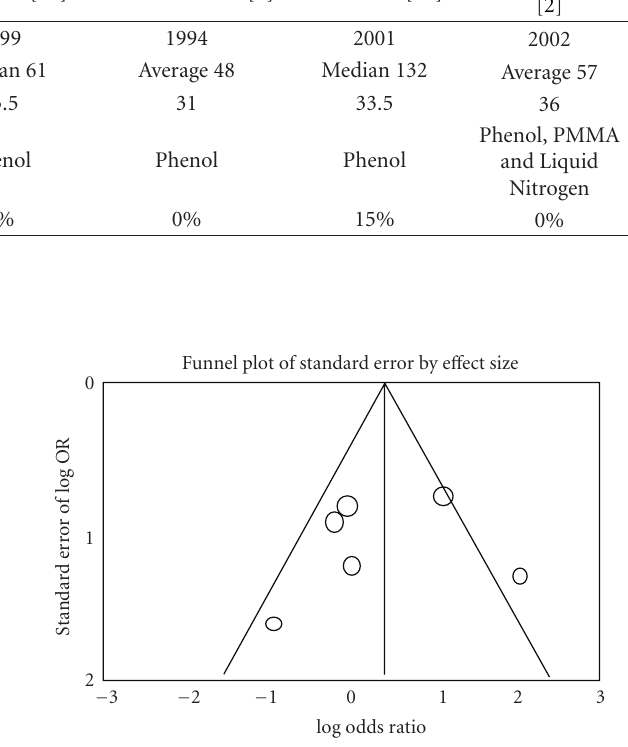
Figure 3: The funnel plot for the 6 studies included in the meta- analysis. The plot shows asymmetrical distribution indicating some publication bias in favor of studies showing an e ff ect for the use of an adjuvant (to the